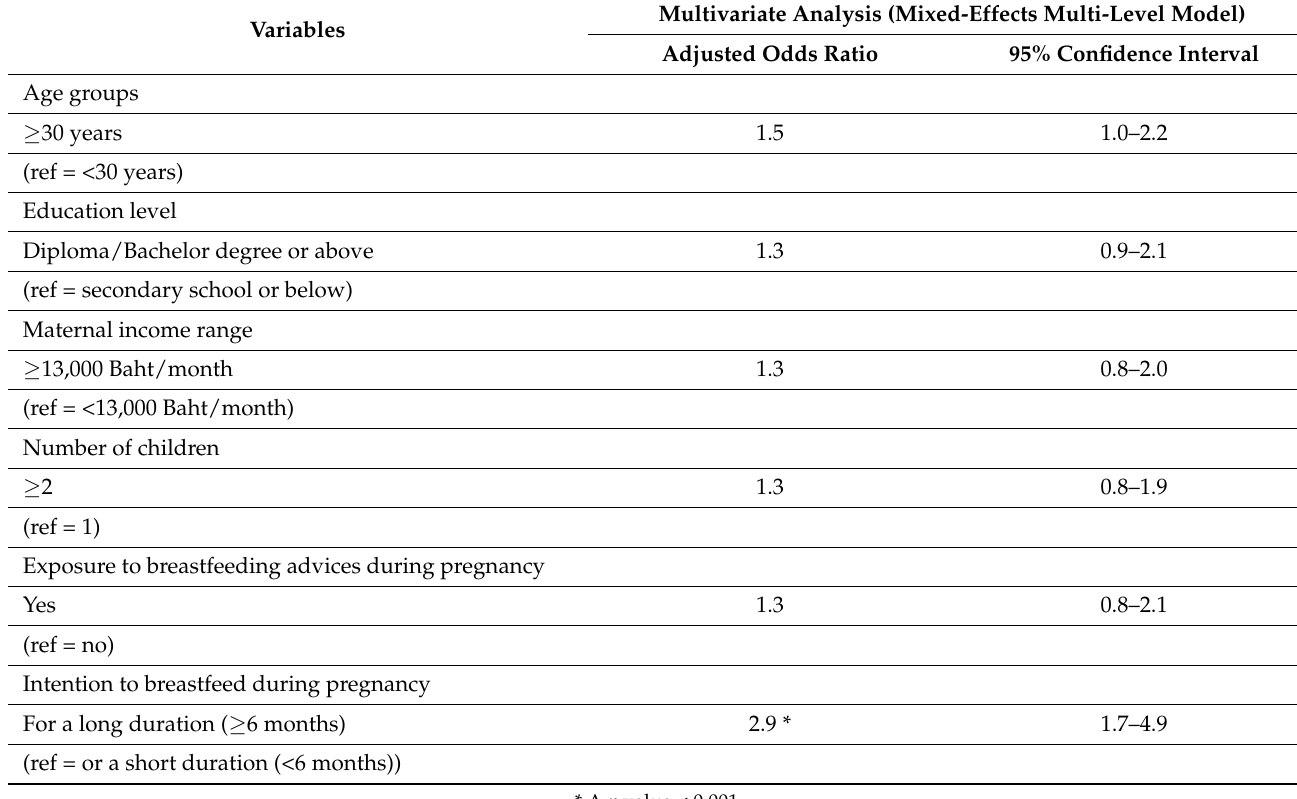
Table 3. Six-month exclusive breastfeeding (EBF) by personal attributes: multivariate analysis (full N).